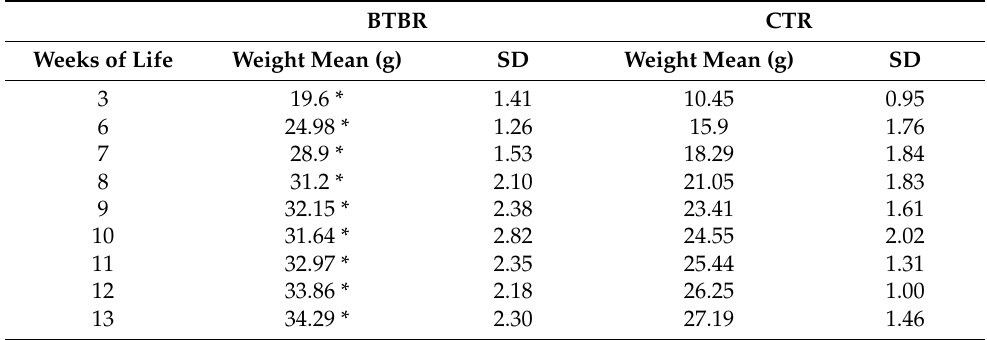
Table 1. Overview of body weight (g) evaluated weekly during the lifespan in the experimental animals: BTBR and CTR mice. Table represents detailed data about weight expressed as mean ± SD, * p < 0.0001 BTBR mice vs. CTR obtained by one-way ANOVA and followed by the Bonferroni correction for multiple comparisons (significant at p < 0.05).